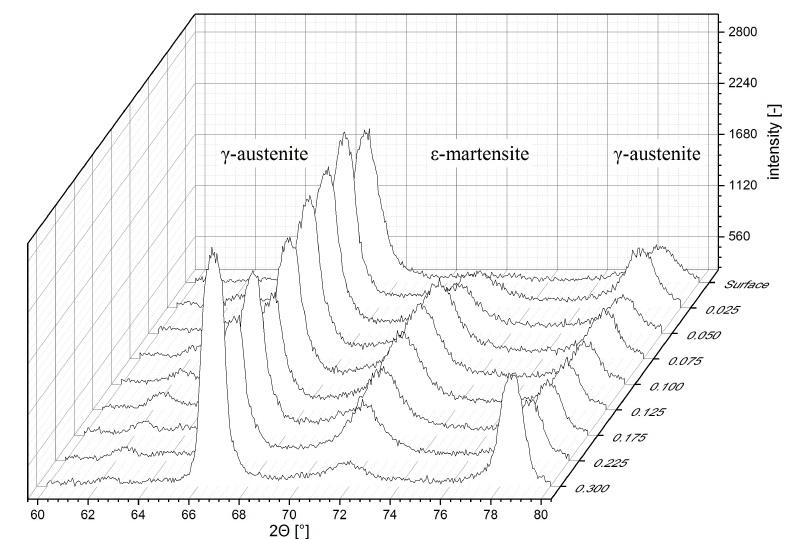
Figure 9. XRD phase analysis using CrK α -radiation revealing a significant martensitic phase fraction upon deep rolling at cryogenic temperature. Peak profiles are plotted as a function of distance from the surface.